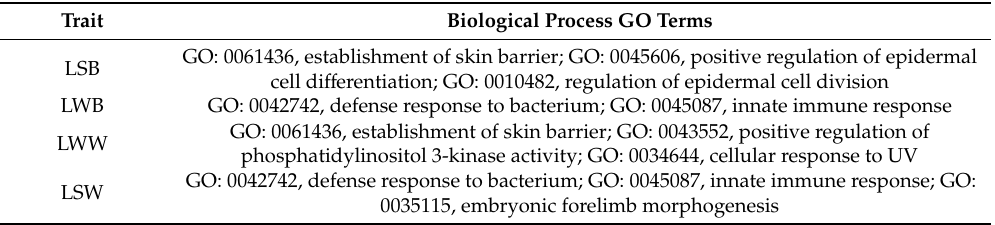
Table 4. Biological process Gene Ontology (GO) terms enrichment analysis